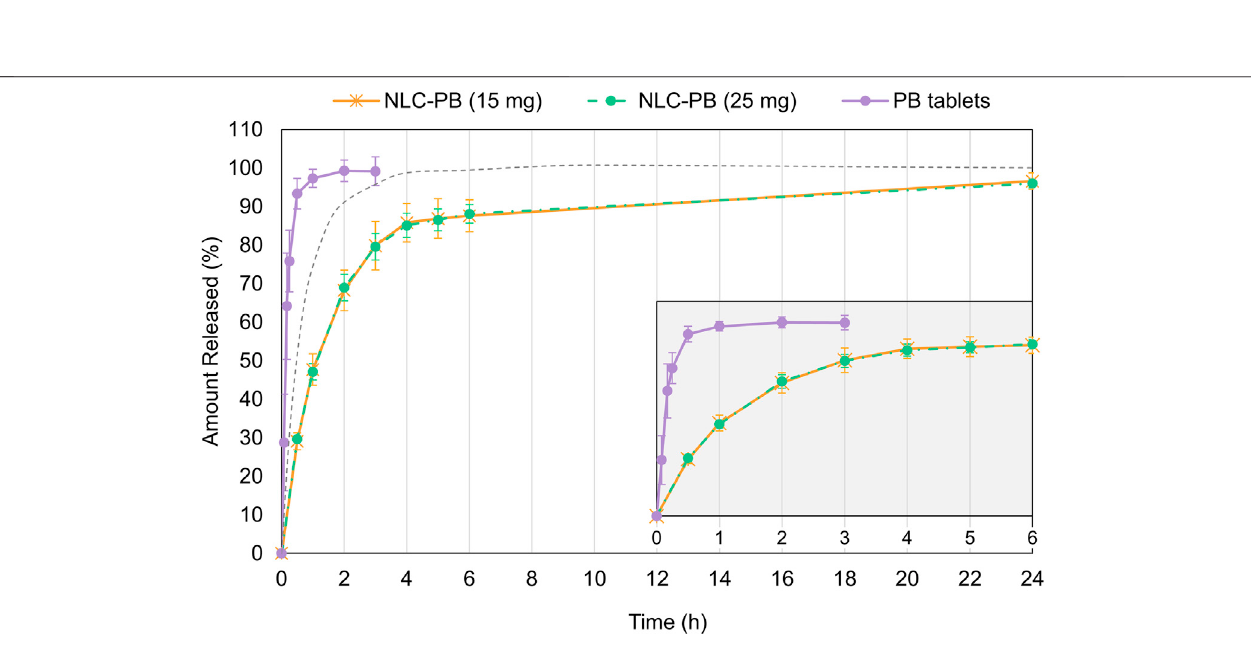
Frontiers in Chemistry |